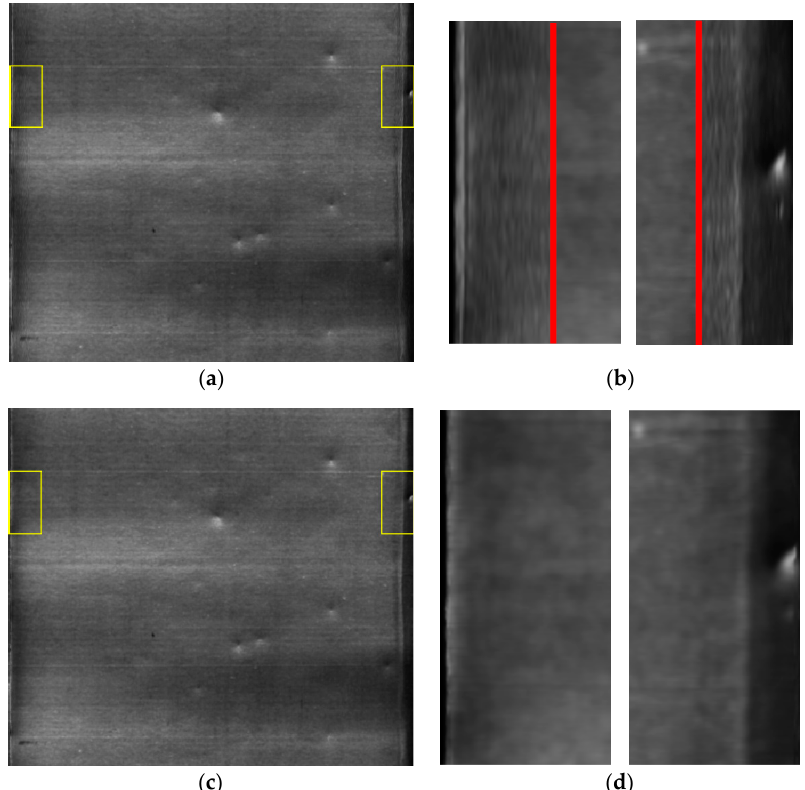
Figure 5. Results of Gaussian filtering. ( a ) Result of partition Gaussian processing; ( b ) Partial magnification result of internal horizontal filtering of image while edge longitudinal filtering; ( c ) Result of traditional Gaussian processing without partition processing; ( d ) Partial magnification result of image global lateral filtering.